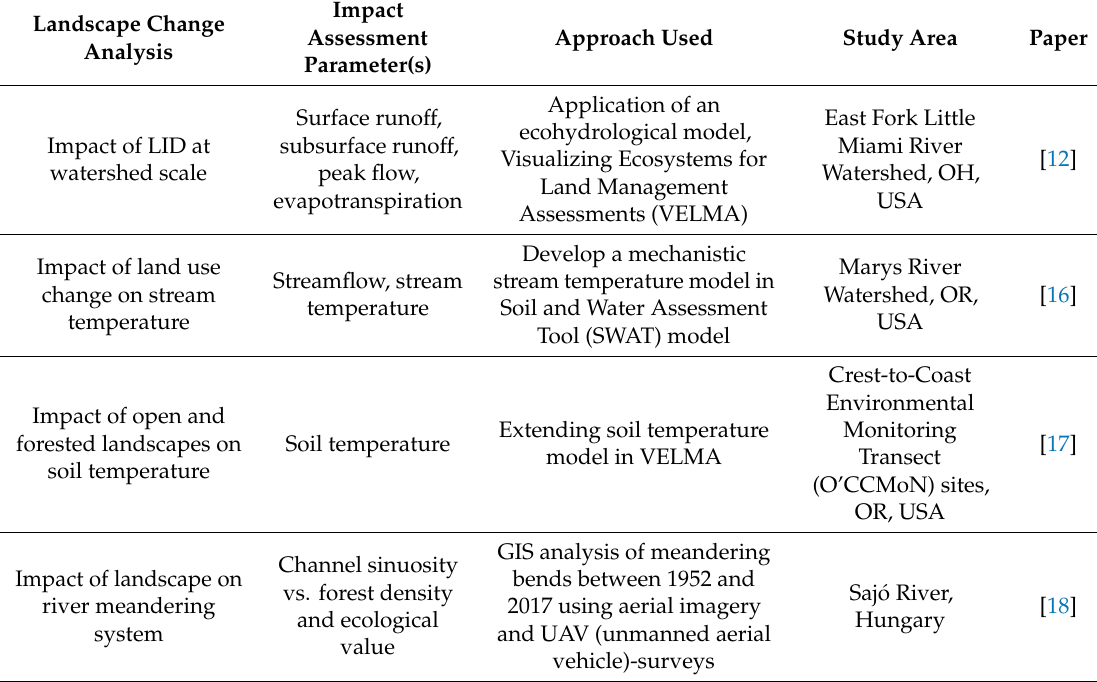
Table 1. Comparative analysis of research presented in Special Issue